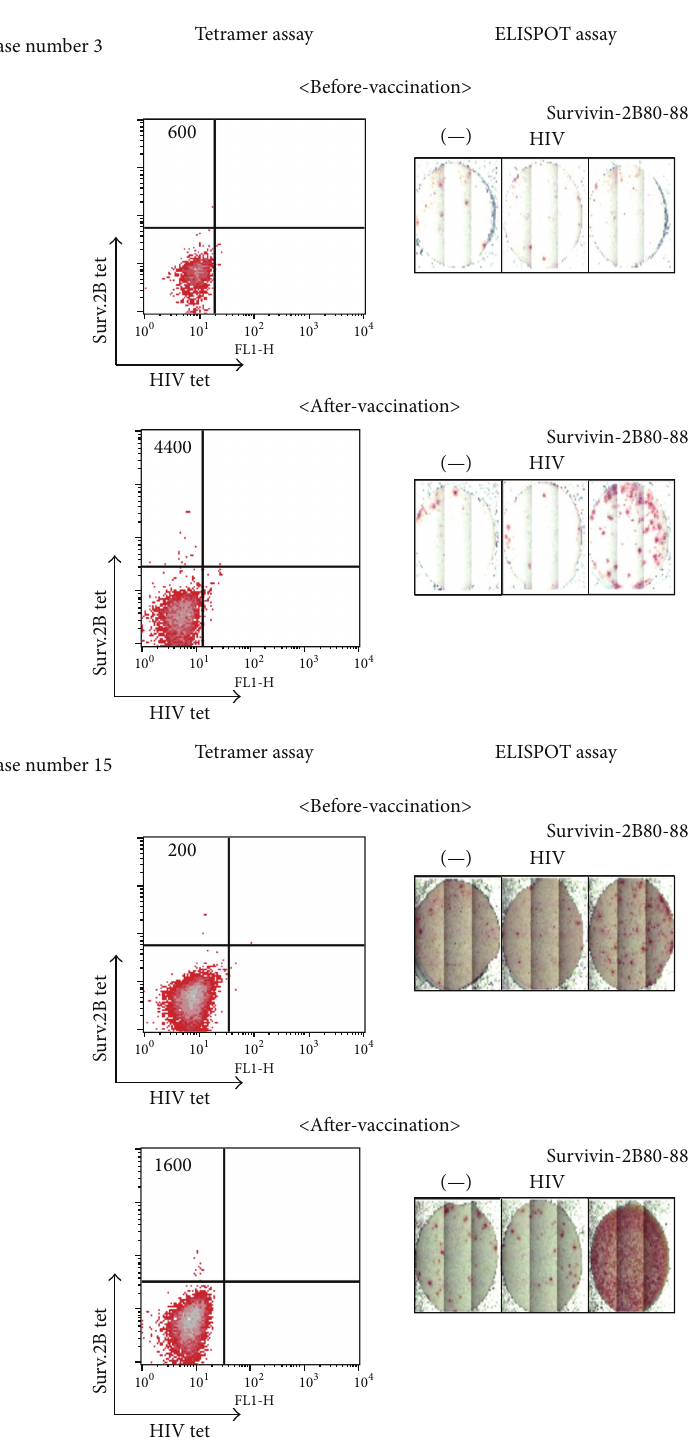
Figure 2: Representative illustration of immunological analysis in patients 3 and 15 who were treated with survivin-2B80–88 plus IFA with IFN alpha. Tetramer and ELISPOT analyses before and after vaccinations. The number in the tetramer analysis indicates survivin-2B80–88 peptide-specific CD8+ T cells among 10 4 CD8+ T cells. ELISPOT: enzyme-linked immunosorbent spot; HIV: human immunodeficiency virus; HLA: human leukocyte antigen; IFA: incomplete Freund’s adjuvant; IFN: